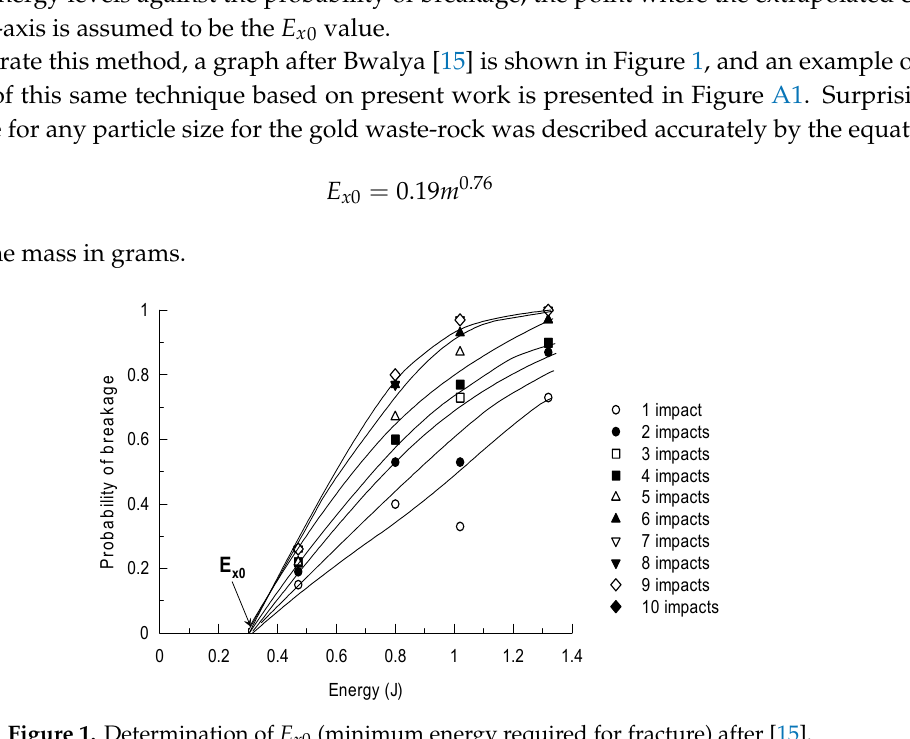
Figure 1. Determination of E x0 (minimum energy required for fracture) after [15].